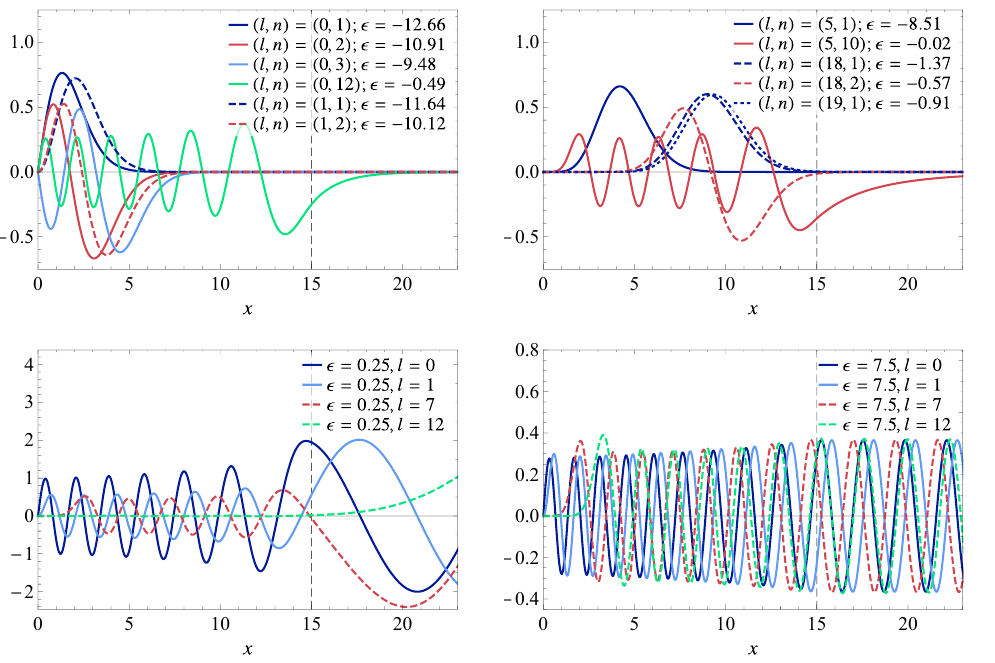
Figure 11. Wavefunctions obtained from solving eqs. (A.4){(A.5) with x c = 15 ; a D = 0. Top: (cid:31) ln ( x ) for bound states. The left (cid:12)gure contains smaller l (0,1) while the right (cid:12)gure has intermediate and high l (5, 18, 19 = l max ), where ( l; n ) = (5 ; 10) is the highest-energy bound state. Bottom: (cid:31) kl ( x ) for scattering states. The left (cid:12)gure displays the partial waves of the scattering states with (cid:15) = 0 : 25 ( E k = 0 : 05(cid:3) D ), while the right (cid:12)gure shows those with (cid:15) = 7 : 5 ( E k = 1 : 5(cid:3) D